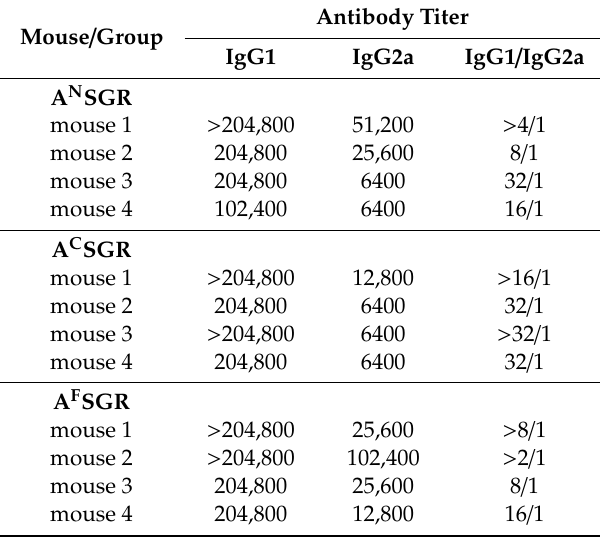
Table 1. Titers of IgG1 and IgG2a antibodies in the serum of vaccinated mice. Mouse/Group